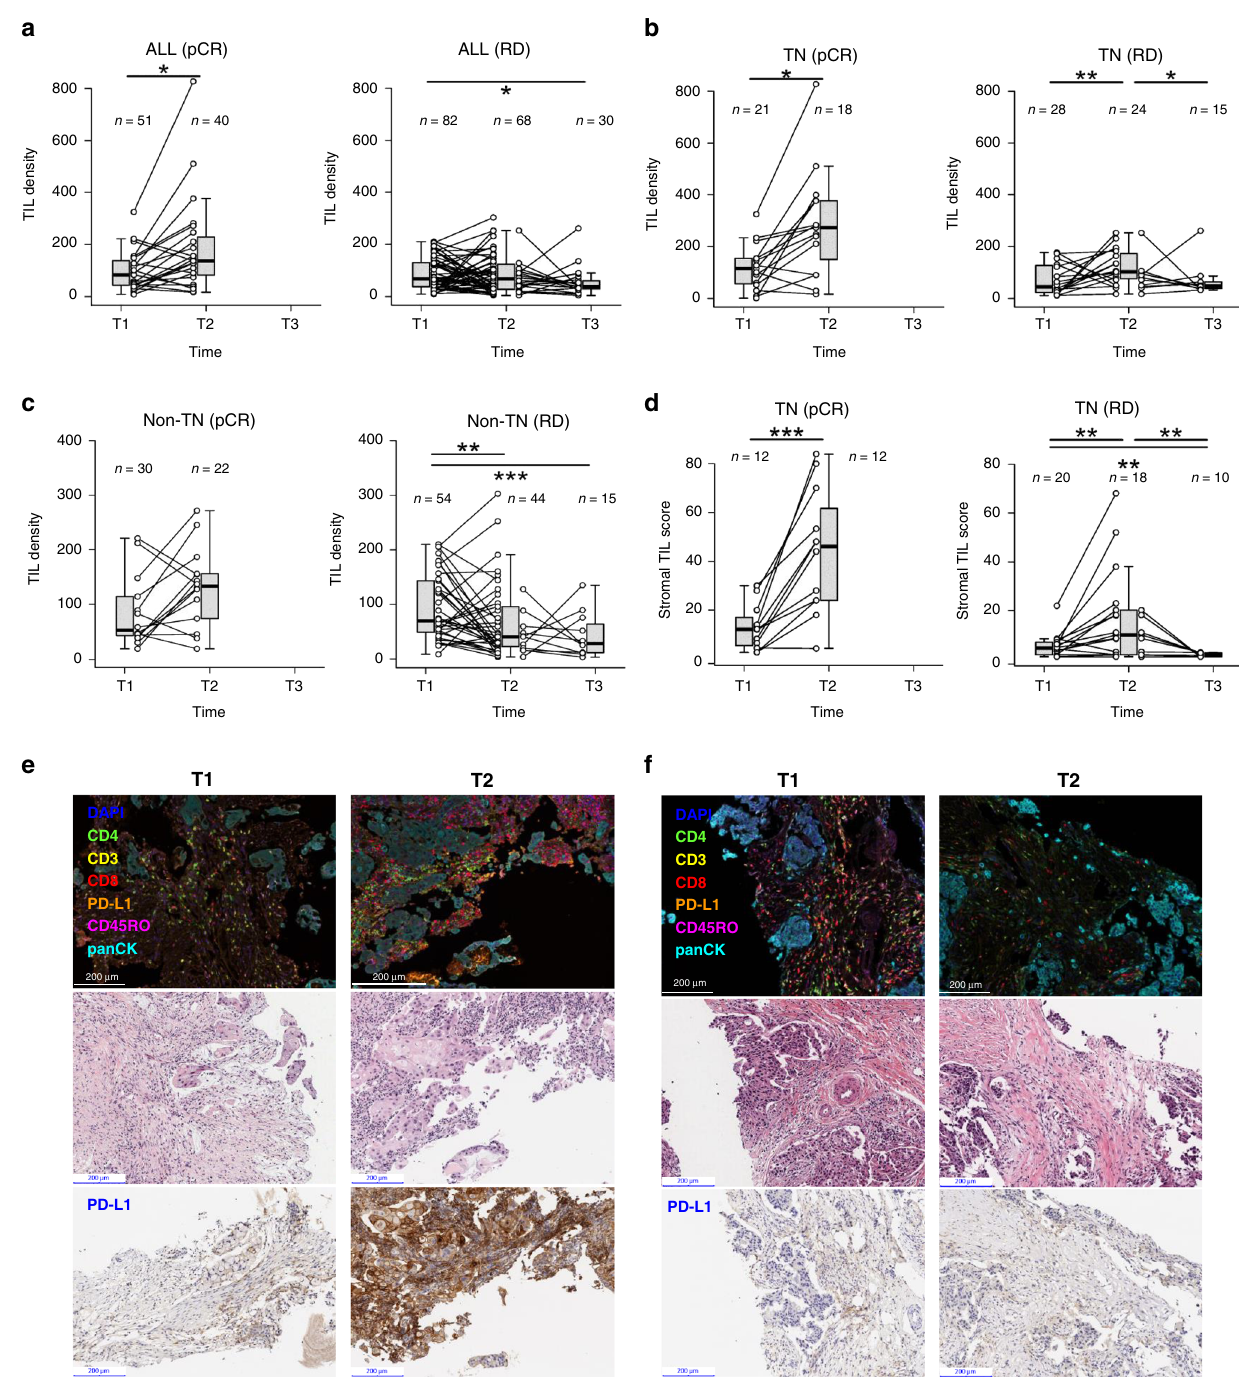
Fig. 4 Tumor in fi ltrating lymphocyte density increased during treatment then decreased below baseline at surgery time. TIL density distributions over three time points were compared between tumors from pCR and RD patients in the overall cohort ( a ), TN ( b ), and non-TN subtypes ( c ). d Distribution of stromal TIL scores over time in TN tumors strati fi ed into pCR and RD groups. Asterisks indicate statistical signi fi cance based on linear mixed effects regression (LMER) adjusting for tumor purity and subtype as covariates. *0.01 < p < 0.05; **0.001 < p < 0.01; *** p < 0.001. See Supplementary Table 2 for exact p -values. For all box-and-whisker plots, the box is bounded by the fi rst and third quartile with a horizontal line at the median and whiskers extend to the maximum and minimum value. Source data are provided as a Source Data fi le. e , f Multiplex immuno fl uorescence (IF), H&E and PD-L1 IHC images showing the same regions of tumors taken at T1 and T2 from a TNBC patient — BR294 ( e ) and a HER2 + patient — BR308 ( f ). Markers include CD45RO, CD3, CD4, CD8, PD-L1, and Pan-CK. Chromogenic IHC and multiplex IF assays were only performed once on tumor biopsy samples following assay optimization. Scale bars in the lower-left corner of the micrographs show 200 μ